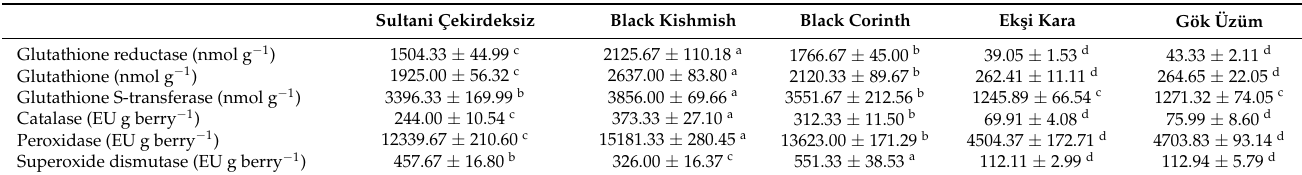
Table 4. Antioxidant enzymes of two stenospermocarpy varieties (Sultani Çekirdeksiz and Black Kishmish); one parthenocarpic variety (Black Corinth), and two seeded varieties (Ek¸si Kara and Gök Üzüm) in the 2020 season.